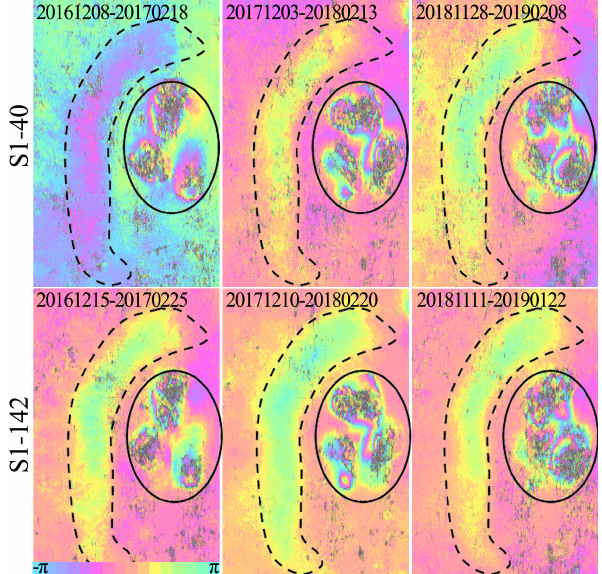
Figure 10. Example of interferograms produced from S1-40 and S1-142 of box (b) in Fig. 3. The ellipses show the primary subsi- dence area induced by underground mining. One color fringe stands for approximately 2.8cm displacement in the LOS. The dashed lines show the secondary subsidence area caused by complicated factors, e.g., groundwater drain out and/or fault activation due to underground